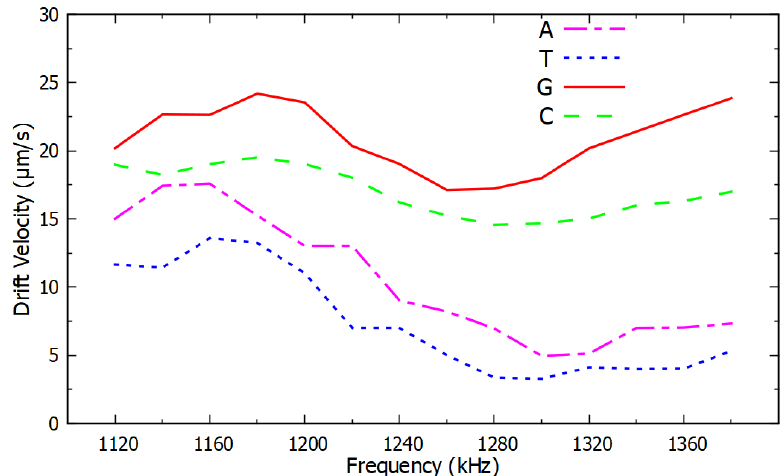
Figure 5. High resolution negative DEP spectra from 1120 kHz to 1380 kHz for the same ssDNA sequences used in Figure 4.